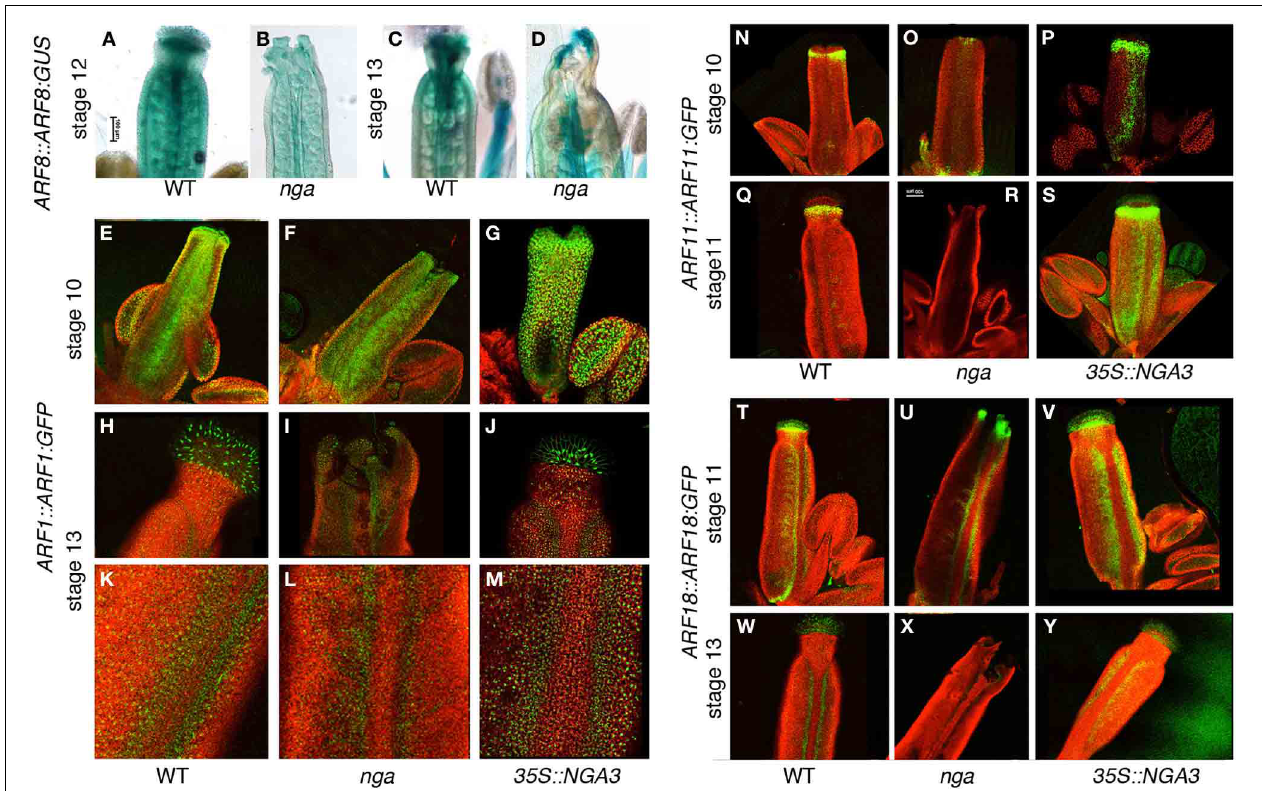
FIGURE 6 | Effect of NGA altered activity on the expression of ARFs throughout gynoecium development. (A–D) Histochemical detection of ARF8::ARF8:GUS activity in wildtype (A,C) , and nga quadruple mutants (B,D) gynoecia at stage 12 (A,B) and at anthesis (C,D) . While in stage 12 pistils ARF8 apical accumulation is clearly reduced (B) , at anthesis shows some expression at valve protrusions formed in the nga quadruple mutant (D) . (E–M) ARF1::ARF1:GFP expression in wildtype (E,H,K) , nga quadruple mutants (F,I,L) and 35S::NGA3 gynoecia (G,J,M) at stage 10 (E–G) and at anthesis (H–M) . (H–J) show close up views of the apical domain, and (K–M)